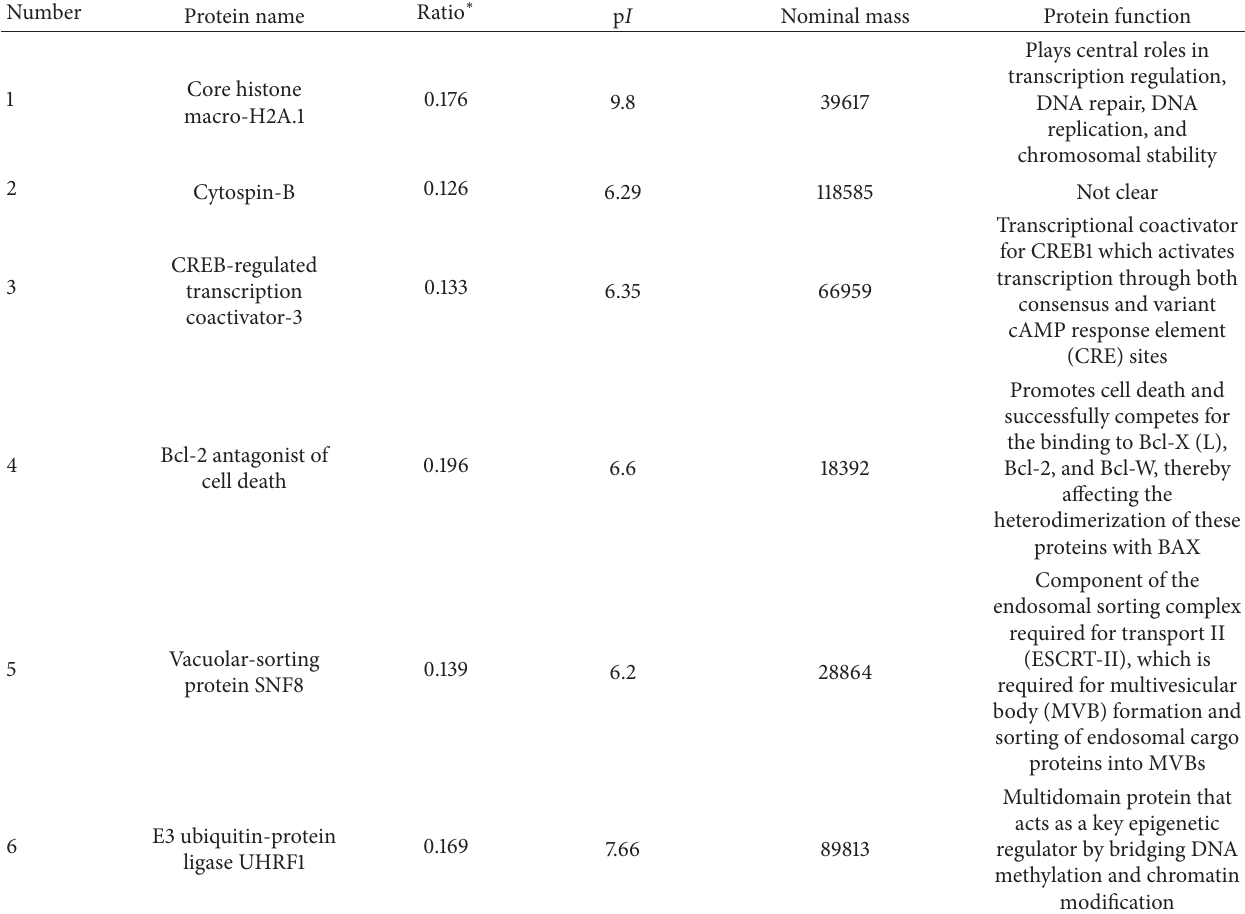
Table 1: Downregulated proteins in GES-1 cells treated with deoxycholic acid (ratio <